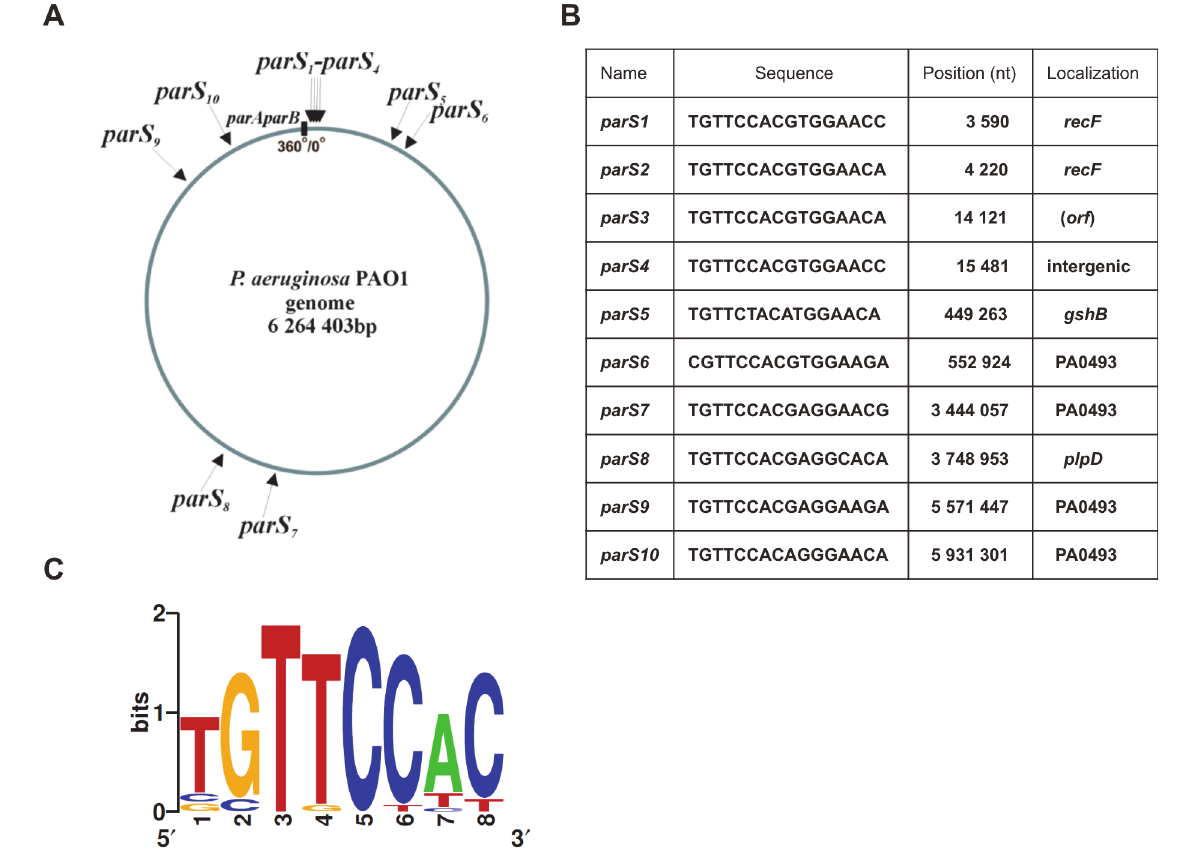
Fig 1. The parS sites and their localization in the Pseudomonas aeruginosa genome. (A) Circular map of the P . aeruginosa genome with locations of putative ParB binding sequences [9]. Position of the parAparB operon is shown as black rectangle, grey arrow marks oriC , black arrows indicate predicted parS sites. (B) Nucleotide sequences, genomic coordinates and gene locations of the parS sites. The sequences are presented in a clockwise configuration. The coordinates are given according to the genomic sequence of the PAO1-UW strain [69]. (C) Sequence logo for all twenty 8-bp half-sites in the P .